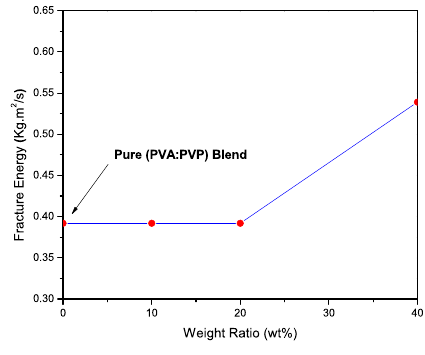
Figure 10: Fracture energy of pure and PVA:PVP poly- mer blend films reinforced with different weight ratios of CdCl 2 · H 2 O salt.